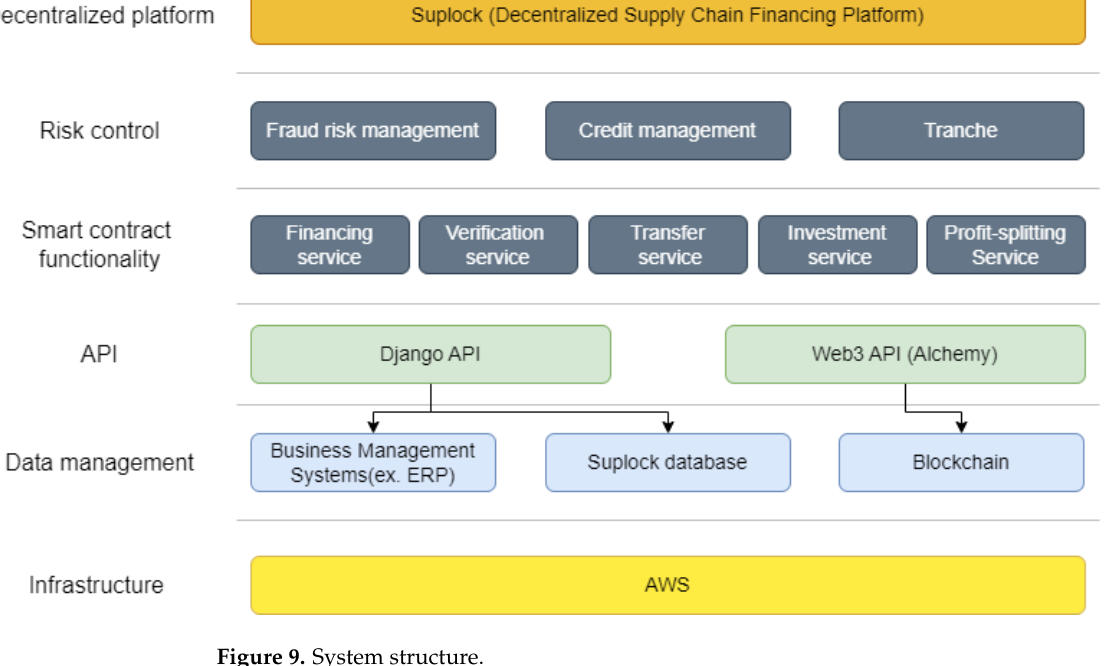
Figure 9. System structure.